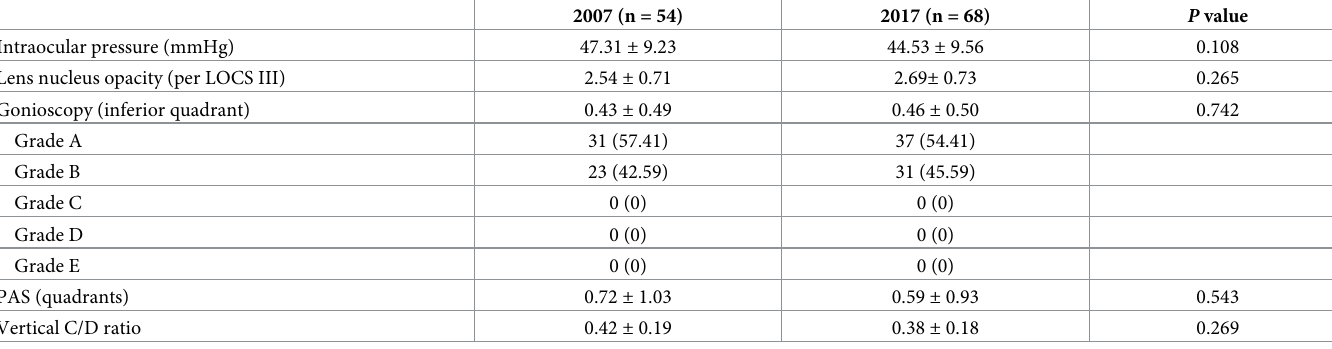
Table 3. Clinical characteristics of patients with acute primary angle closure in 2007 and